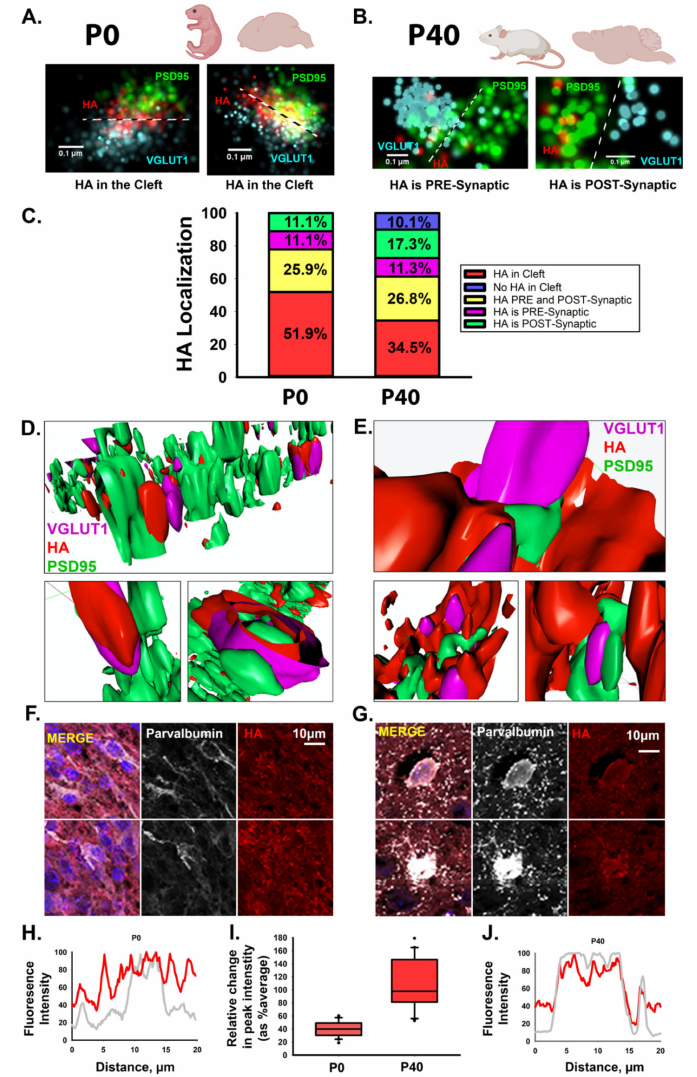
Figure 1. Hyaluronan exhibits a dynamic developmental expression at excitatory synapses. ( A ) Representative dSTORM images of HA within the synaptic cleft between excitatory synaptic markers, VGLUT1 and PSD95, in mouse P0 cortical slices. Cyan: pre-synaptic marker VGLUT1; green: post-synaptic marker PSD95; red: HA. ( B ) Representative dSTORM images of HA outside of the synaptic cleft, yet near synapses, in P40 mouse cortical slices. ( C ) To illustrate the shift in HA localization from P0 to P40 we used percent stacked bar charts to look at the distribution of HA localization at excitatory synapses visualized by dSTORM microscopy. Percentages are based on the distance from HA to each synaptic marker. HA in the cleft between pre- and post- synaptic is shown in red. HA near (within 100 nm) of the pre- and post-synaptic marker is labeled as HA localized to both the pre- and post-synaptic compartment (yellow). HA preferentially localizing to one synaptic compartment is labeled as HA localized to either the pre- or post- synaptic compartment (presy- naptic: magenta; postsynaptic: green). Synapses lacking HA are labeled in blue. n = 168 synapses from 4 brain samples for each P0 or P40 time point. ( D , E ). Three-dimensional reconstruction of mouse excitatory synapses using Airyscan processing reveals that HA is clearly present between synaptic markers on postnatal day 1 (P0) ( D ) but shifts to surround excitatory synapses at P40 ( E ). ( F – J ) Inhibitory interneurons in P0 ( F ) and P40 ( G ) mouse cortical brain slices, stained for DAPI in blue, parvalbumin (inhibitory interneurons) in white, and HA in red. While HA is ubiquitous around the cells at P0, condensed perineuronal nets are absent. By contrast, HA is found in the form of a visibly condensed perineuronal net around the soma at